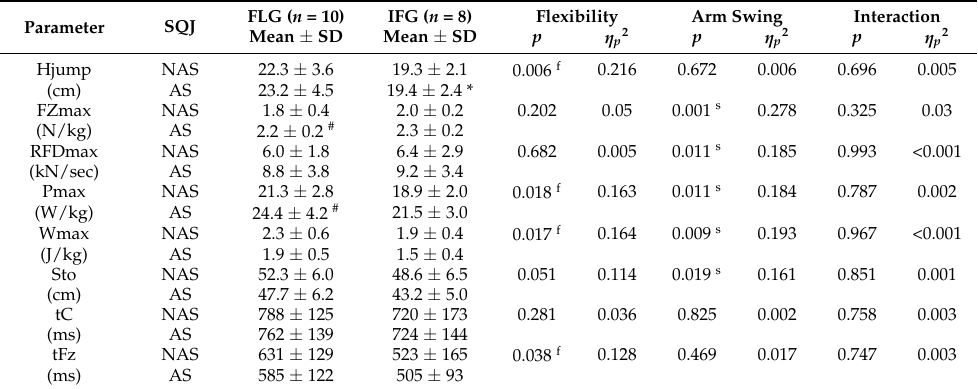
Table 2. Results of the examined parameters for the vertical squat jump (SQJ) with (AS) and without (NAS) the use of an arm swing executed by the players of the flexible (FLG, n = 10) and inflexible (IFG, n = 8) groups. FLG ( n = 10) IFG ( n = 8) Flexibility Arm Swing Interaction Parameter SQJ Mean ± SD Mean ± SD p η p 2 p η p 2 p η p 2 Hjump NAS 22.3 ± 3.6 19.3 ± 2.1